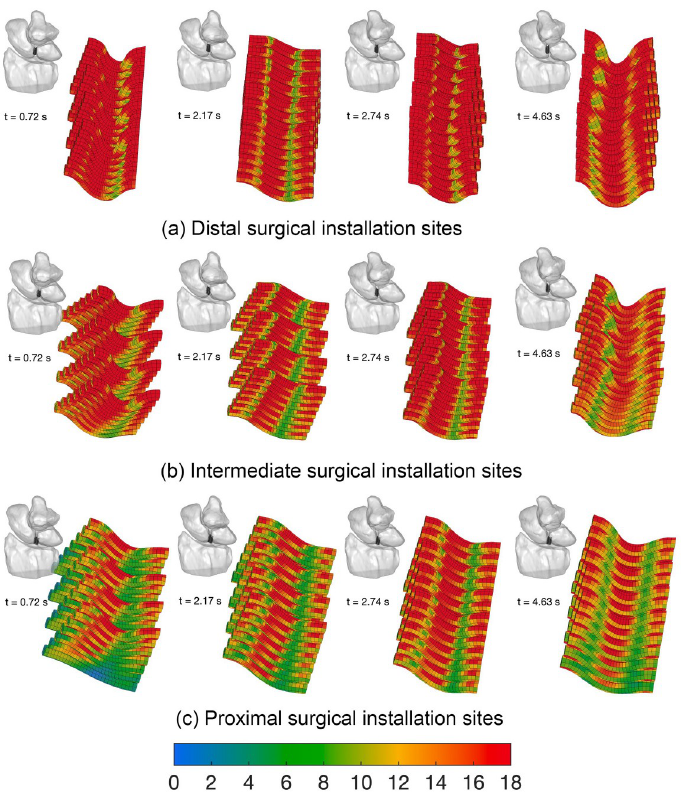
Fig 15. Von Mises stress distribution on the 3 mm ligament-scaffold at three installation surgical sites. Chosen time corresponds to maximum peaks in von Mises stress (Fig 13). (a) The distal (Fig 5b); (b) intermediate (Fig 5c); (c) proximal (Fig 5d) in the dorsal view of the